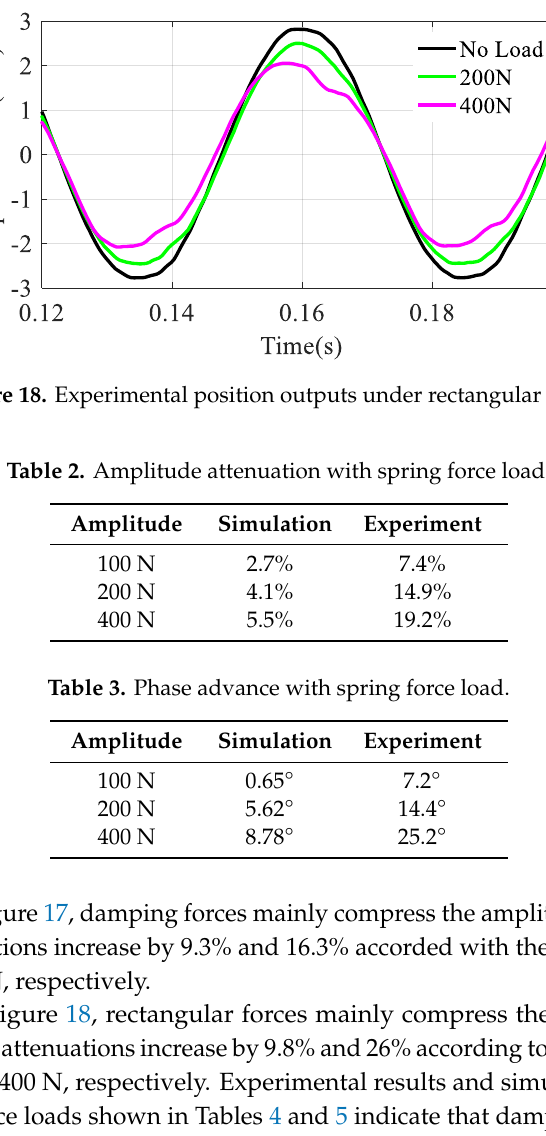
Figure 17. Experimental position outputs under damping forces.